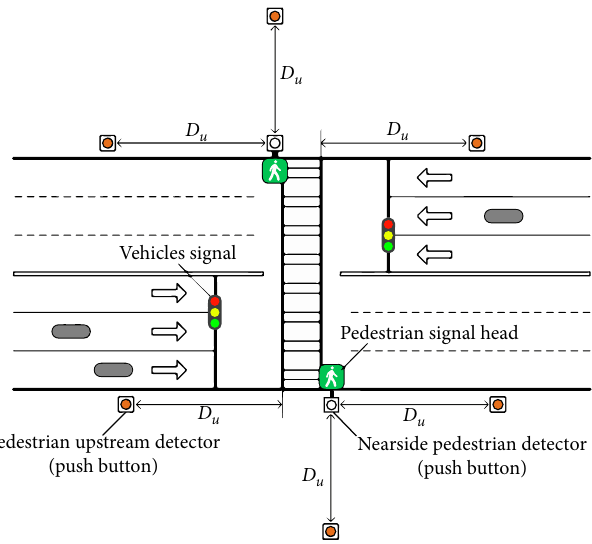
Figure 2: Pedestrian upstream detection (UD) strategy for mid-block